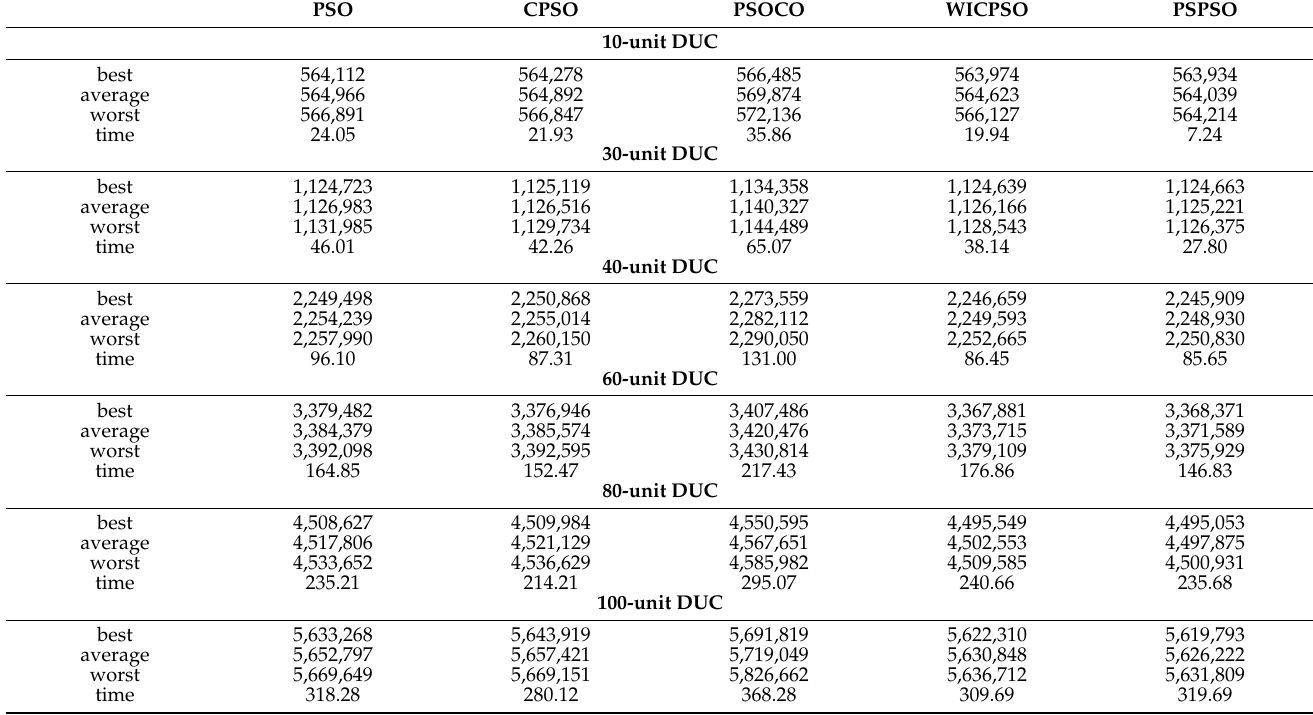
Table 13. System Cost ($) and Computational Time (sec) of the 10-unit UC problem with increased. Dimension compared with other PSO